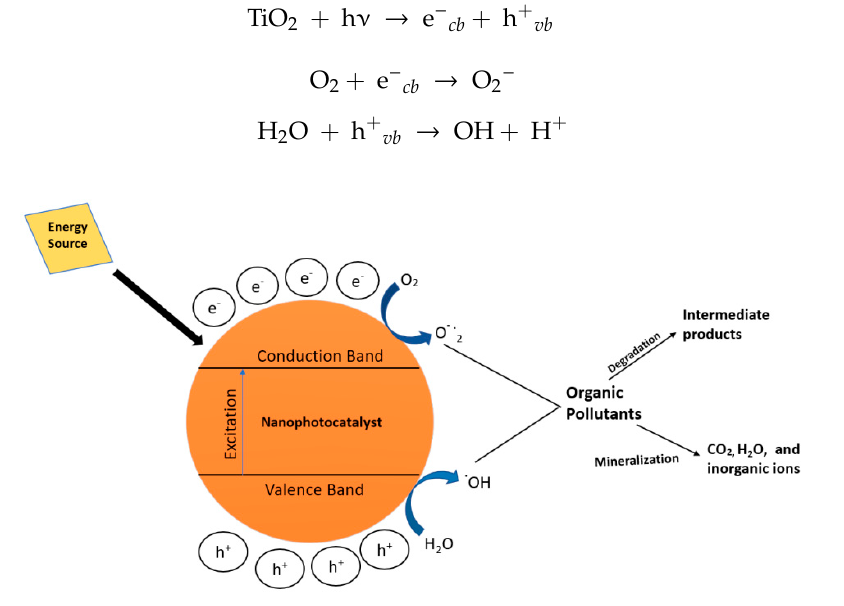
Figure 2. General mechanism of toxic organic compound degradation through nanophotocatalysts.